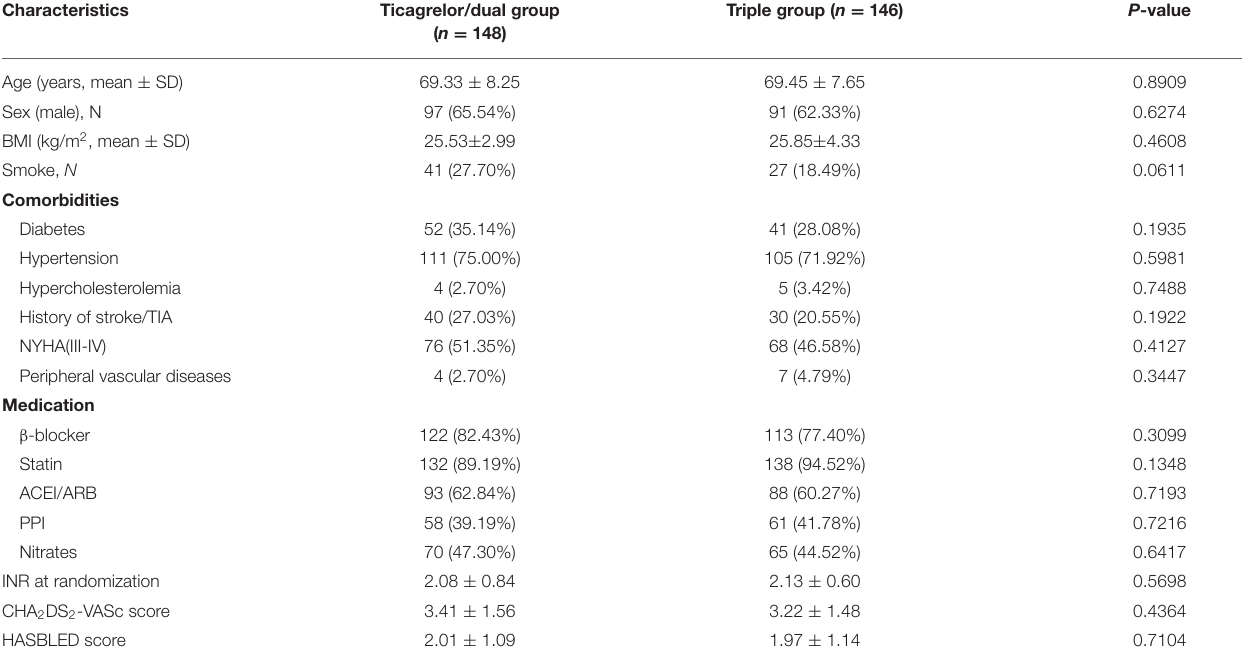
TABLE 1 | Characteristics of the patients at baseline.